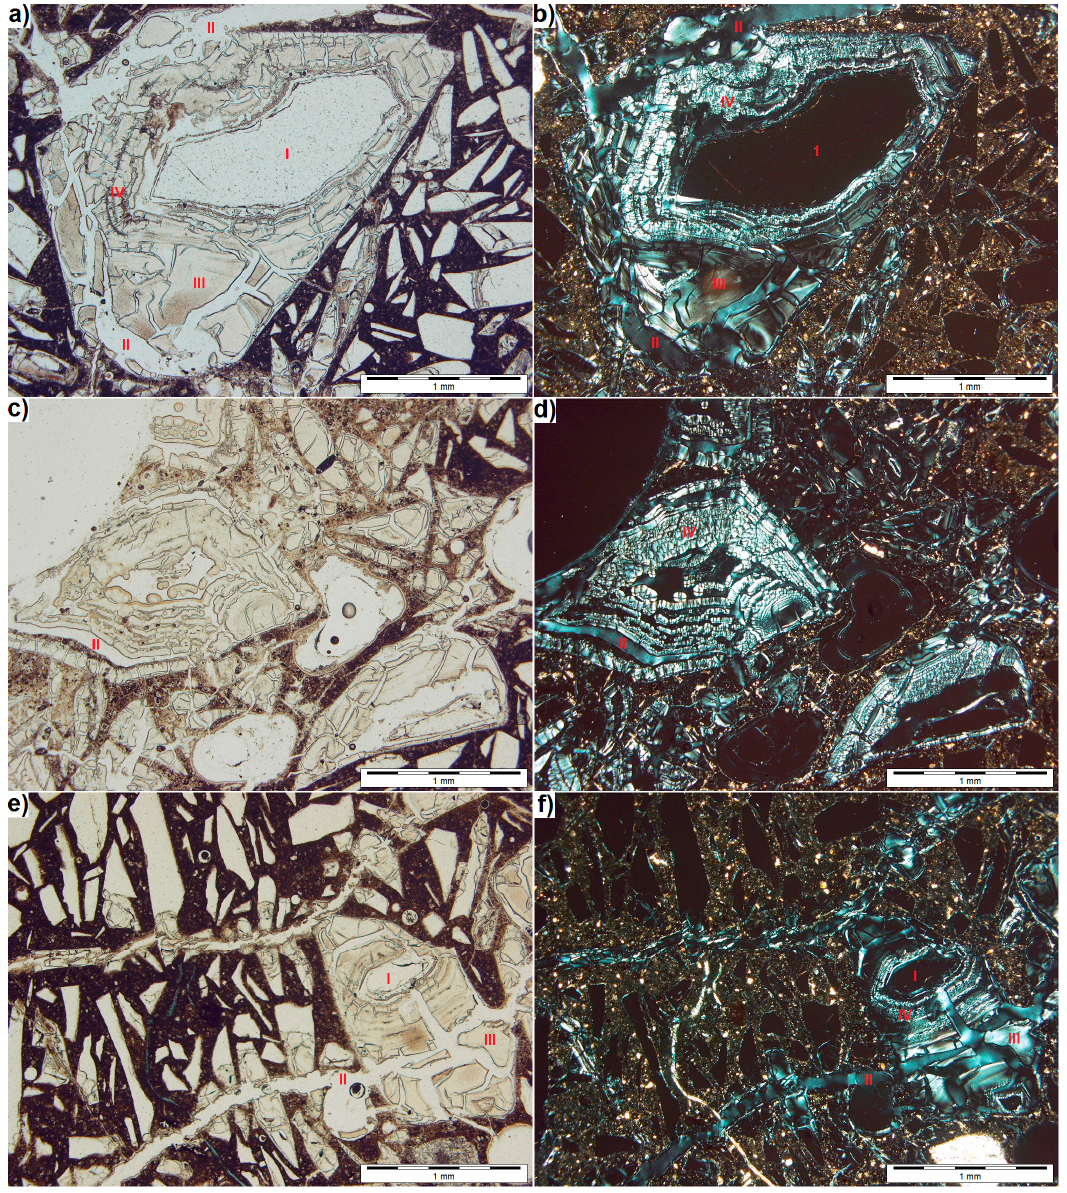
Figure 6. Thin section observed under transmitted light, obtained with one (left) and two polarizers (right); I – non-degraded glass, II – impregnating agent, III – degraded glass, IV – alkali silica gel. ( a ), ( b ) cracked large grain of waste glass; ( c ), ( d ) gel in the place of glass grain next to the air pore; ( e ), ( f ) cracks around the degraded glass grain.